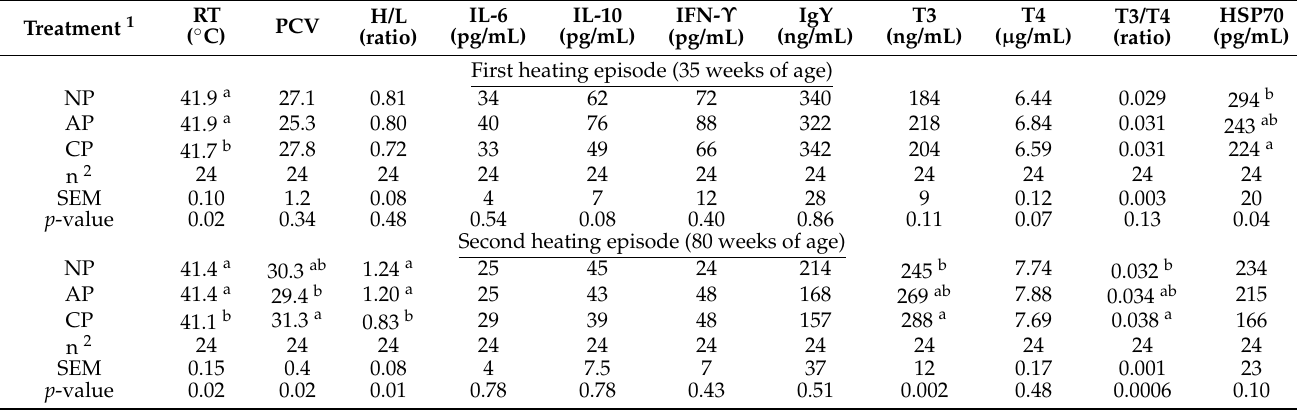
Table 3. The effects of cooled perches on plasma heterophil/lymphocyte ratio, immunological parameters, and thyroid hormones of caged laying